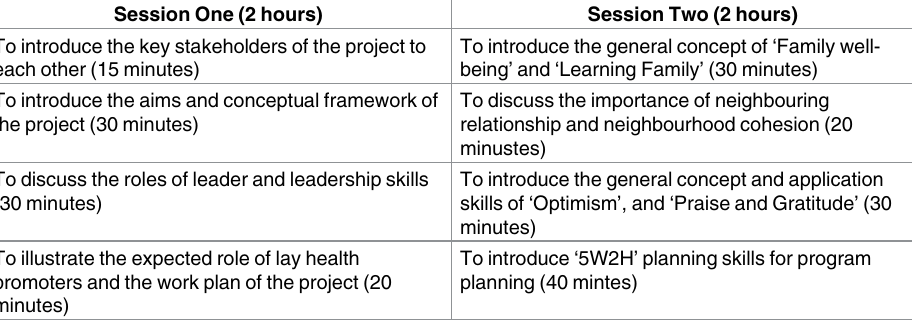
Table 1. The training content of the train-the-trainer